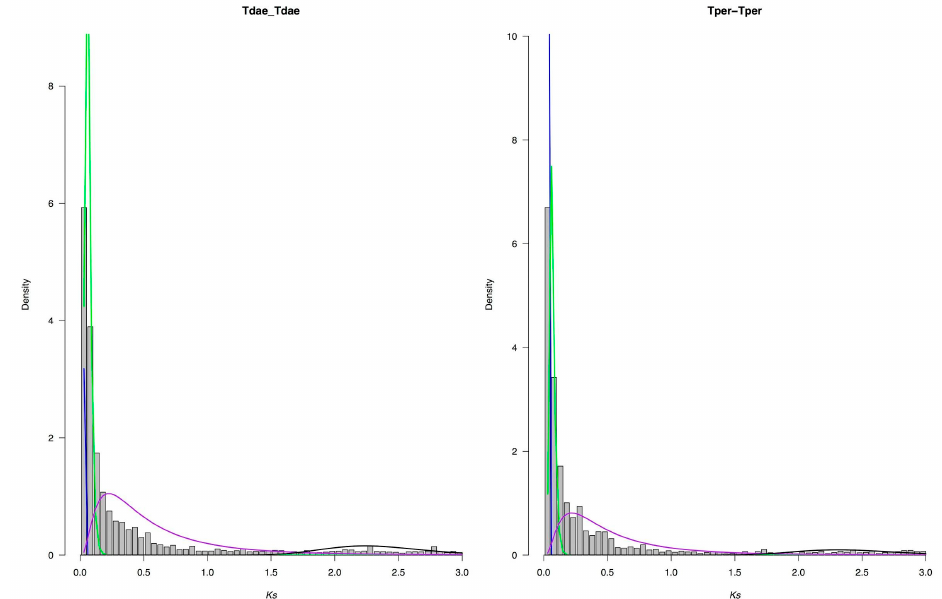
Figure 7. Ks distribution plots for T. daenensis and T. persicus. The components are (1) background gene duplications (green), (2) putative whole-genome duplications (purple), (3) alleles or sequencing errors resulting in high identity transcripts (blue), and (4) potential whole-genome duplications with low support (black).